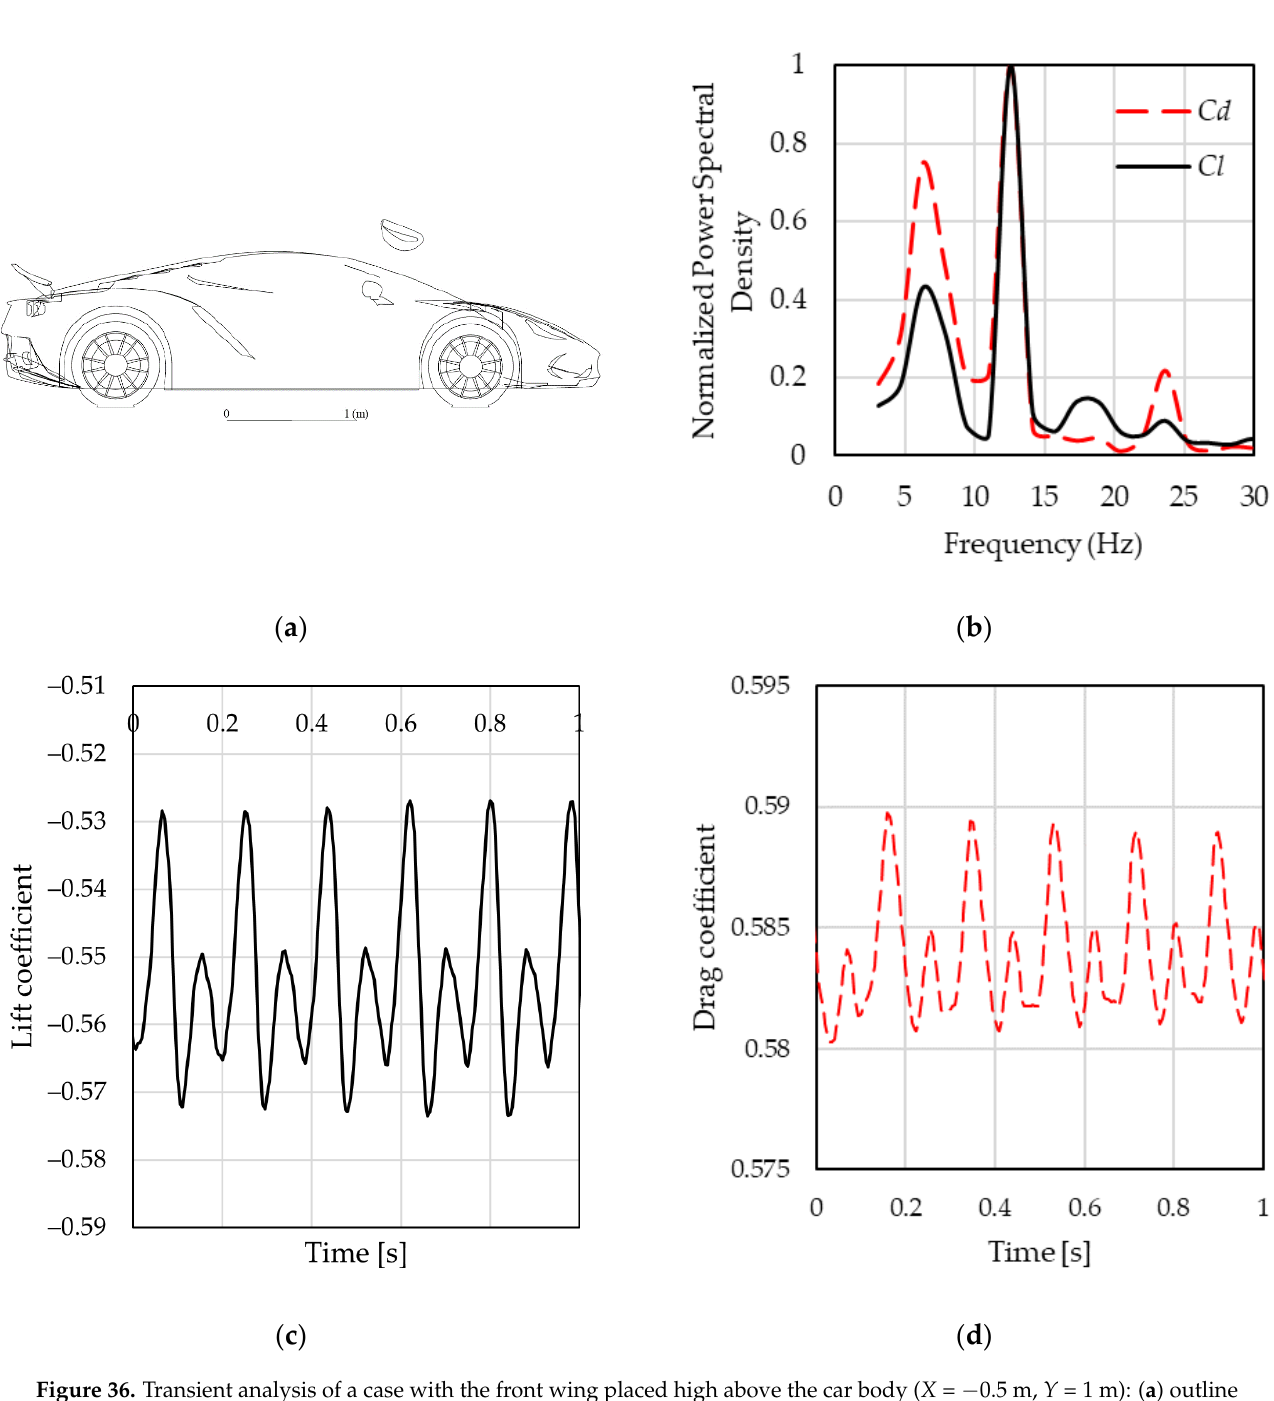
Figure 36. Transient analysis of a case with the front wing placed high above the car body ( X = − 0.5 m, Y = 1 m): ( a ) outline of the geometry, side view; ( b ) FFT analysis; ( c ) total lift coefficient as a function of time; ( d ) total drag coefficient as a function of time.